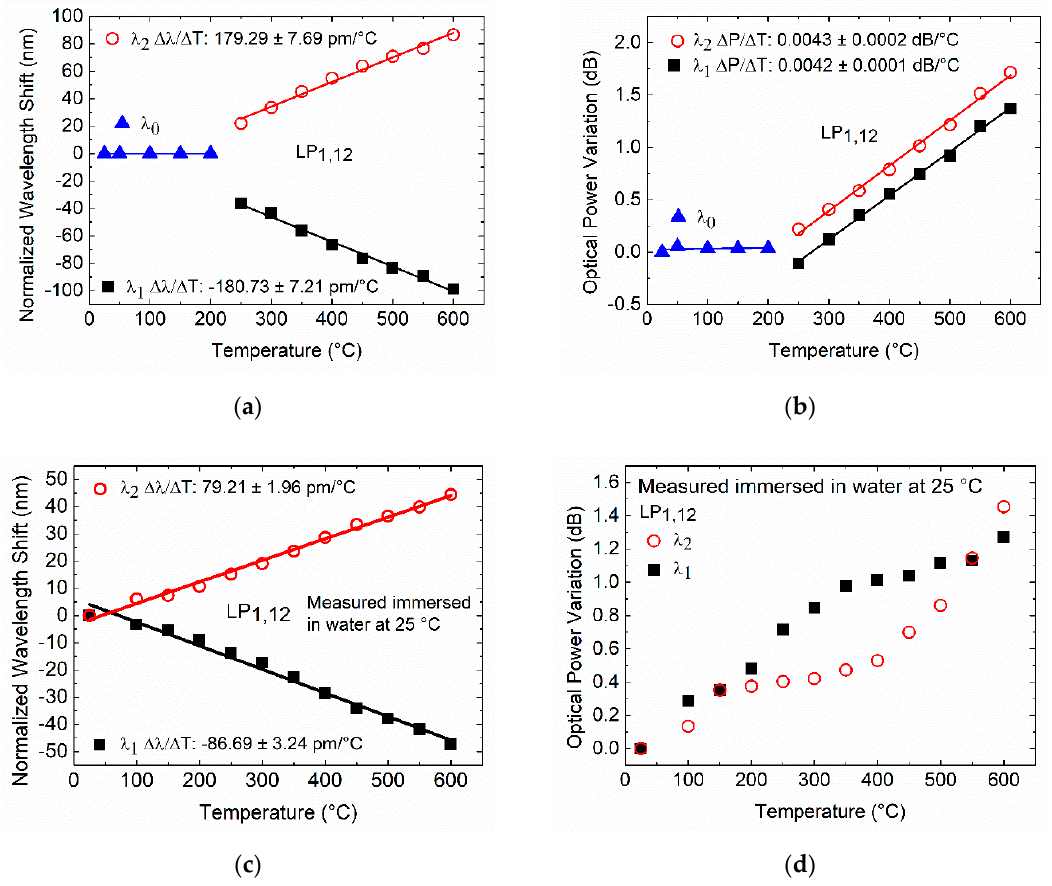
Figure 10. Fs laser 182.7 µm TAP LPFG: ( a ) normalized wavelength shift, and ( b ) normalized optical power variation in air at room temperature as a function of the annealing temperature; ( c ) normalized wavelength shift, and ( d ) normalized optical power variation in water at room temperature, as a function of the annealing temperature.